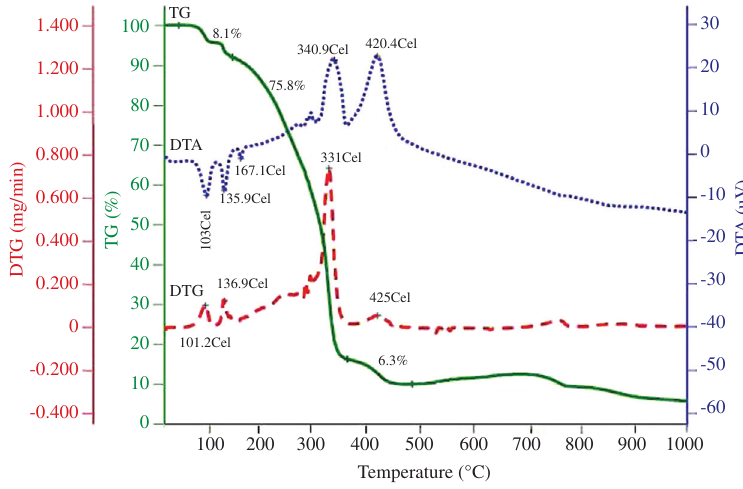
Figure 6 Thermal analyses curves of the Co